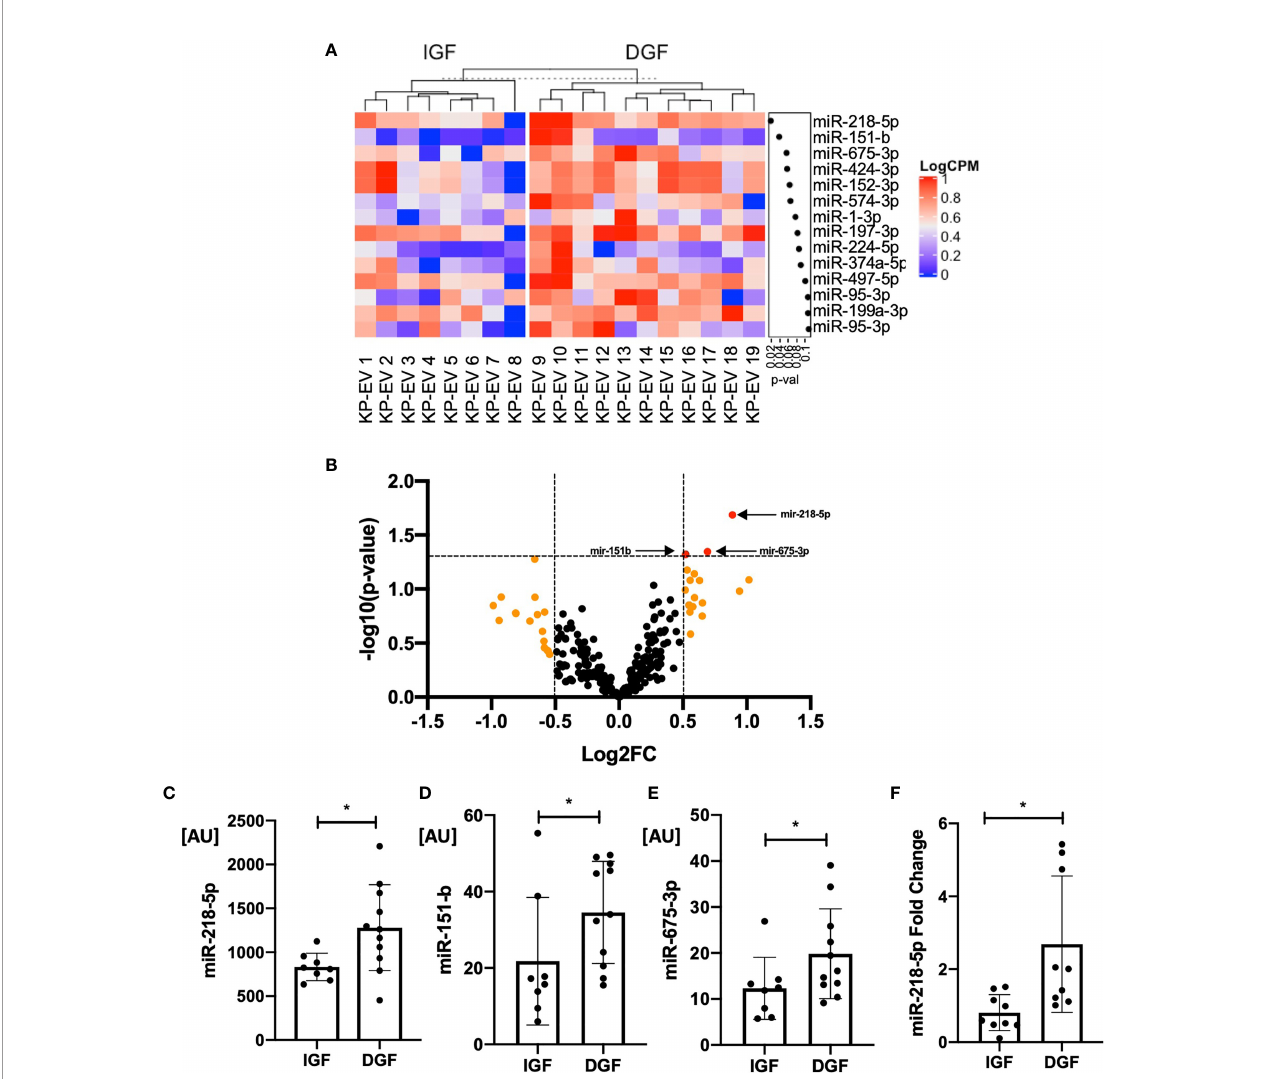
FIGURE 5 | KP-EV miRNA pro fi le differentiates kidney transplant recipients with IGF and DGF. (A) Heat map of miRNA expression pro fi le of donor KP-EV of recipients with DGF (n=11) as compared to IGF (n=8). RNA was extracted from KP-EV, which were enriched from the perfusion fl uid of human kidney deceased donors. (B) Volcano plot of miRNA expression of KP-EV of kidney recipients with DGF as compared to IGF. The fold change of each miRNA is plotted on the X axis in log2 scale and their signi fi cance level ( – log10-p-value) is plotted on the Y axis. Orange dots represent miRNA with a fold change ≥ 1.4 and red dots represent miRNA with p values ≤ 0.05. Three miRNA pointed by arrows (red dots) were identi fi ed as candidate miRNA upregulated in patients with DGF with a fold change ≥ 1.4 and p values ≤ 0.05. (C – E) Bar graphs of expression values of candidate miRNA levels of the top three hits that were found to be upregulated in recipients with DGF. (F) qPCR quanti fi cation of miR-218-5p expression in a different set of KP-EV samples of patients with IGF (n=9) and DGF (n=9). *represents p-values ≤